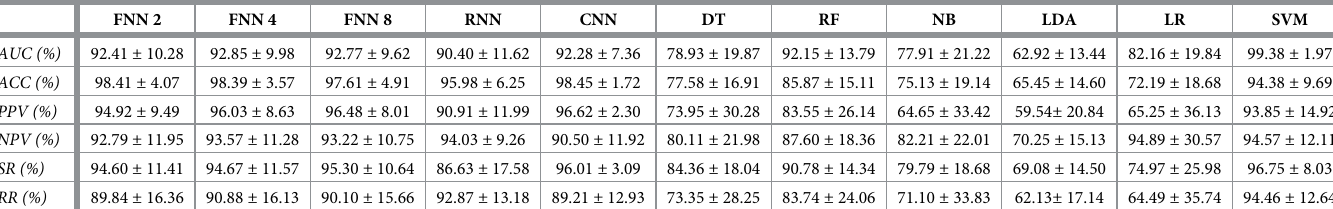
Table 7. Mean and standard deviation of diagnostic performance of all the machine learning models.